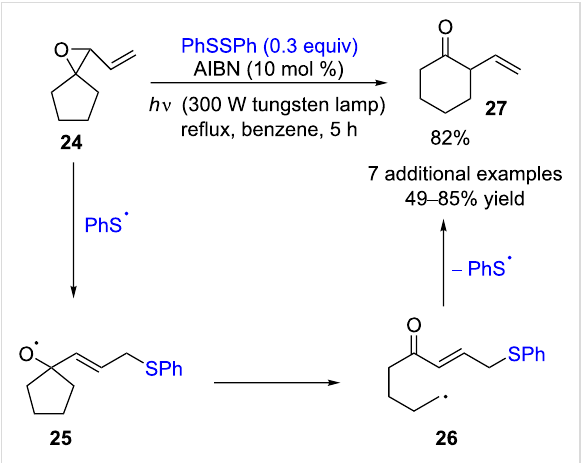
Scheme 7: Disulfide-catalyzed ring expansion of vinyl spiro